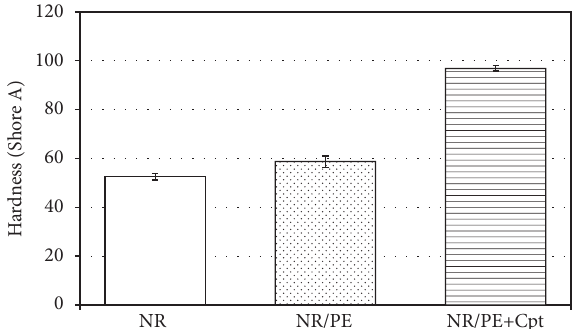
Figure 6: Hardness of neat NR, NR/PE blend, and NR/PE blend treated with compatibilizer.